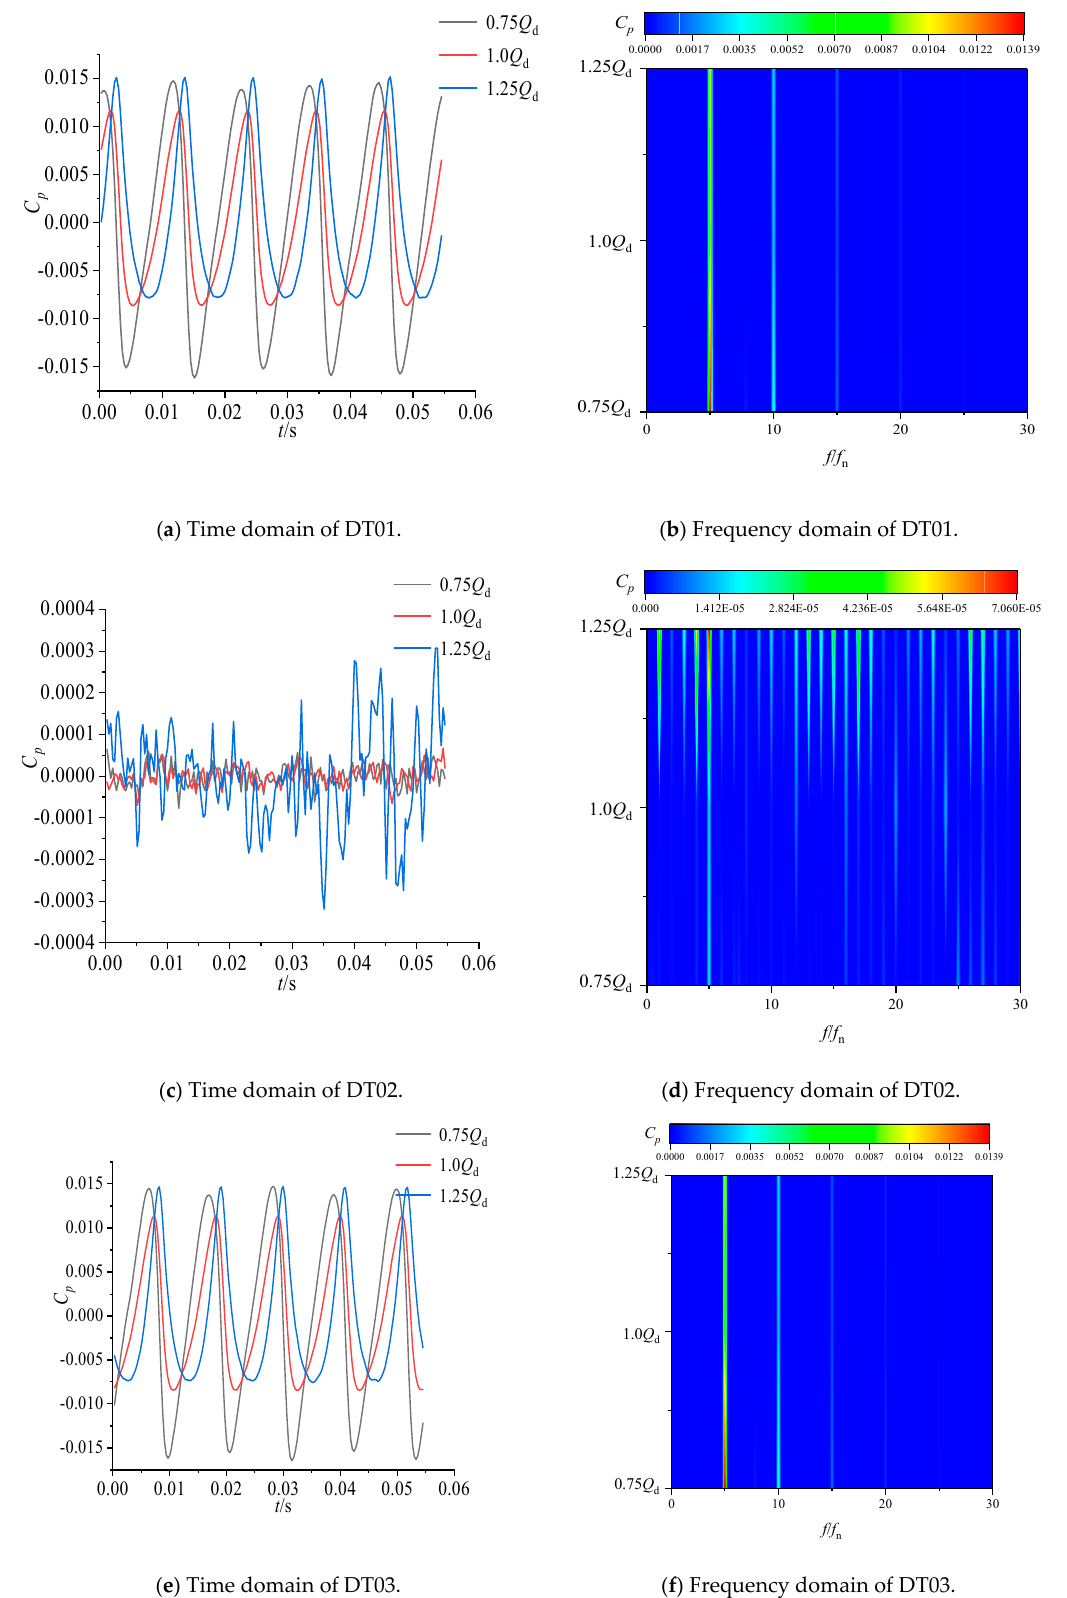
Figure 25. Time and frequency domain of pressure fluctuation at the outlet of the draft